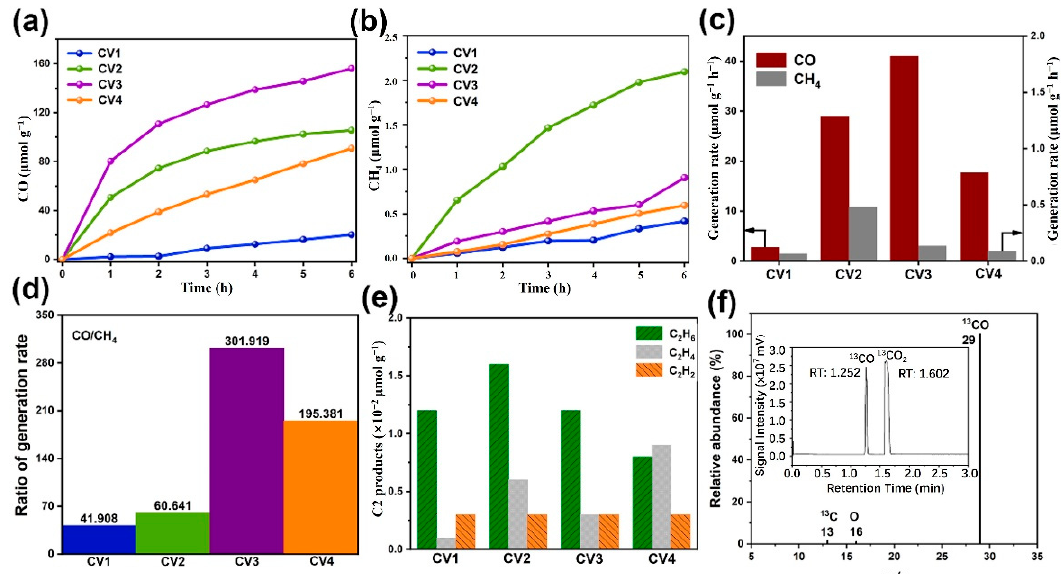
Figure 4. Photocatalytic ( a ) CO yields, ( b ) CH 4 yields, ( c ) the ratio of CO and CH 4 production rates, ( d ) comparison of the photocatalytic selectivity of the samples, ( e ) C2 yields after 6 h photocatalytic reaction, and ( f ) isotopic substitution experiment using 13 CO 2 as the reactant.